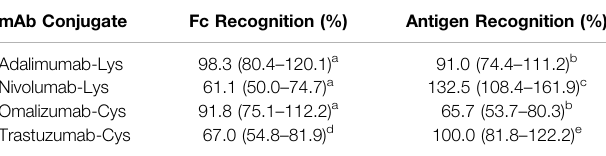
TABLE 2 | Relative performance of conjugated mAbs against the native mAbs as measured by different immunoassay formats. mAb